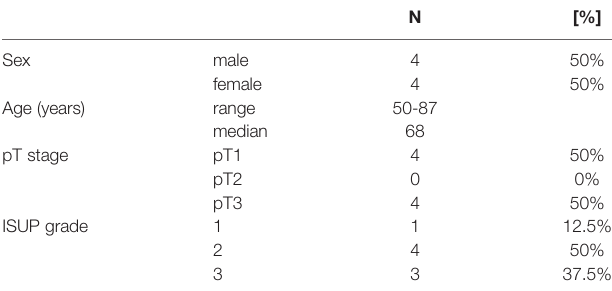
TABLE 1 | Clinicopathological parameters of the included patient